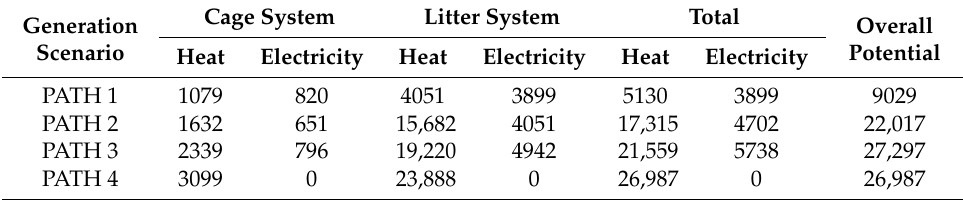
Table 8. Annual technical energy potential of chicken manure in Poland overall, E tech in TJ.